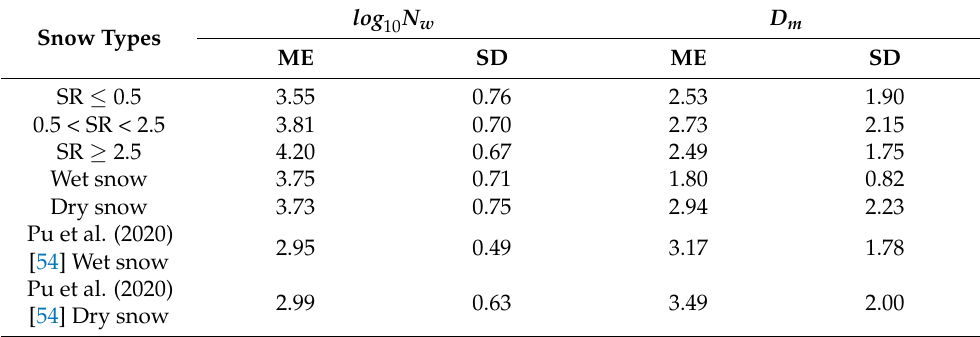
𝑙𝑜𝑔 𝑁 𝐷 (cid:2869)(cid:2868) (cid:3050) and (cid:3040) of stratiform precipitation in Bringi et al. [36]. There are two dashed boxes of convective precipitation on the right side of the dashed line, where the upper